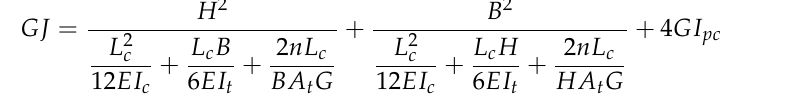
Figure 7. Torsion diagram of a typical cross-section in the equivalent straight truss considering the torsional sti ff ness of chords.